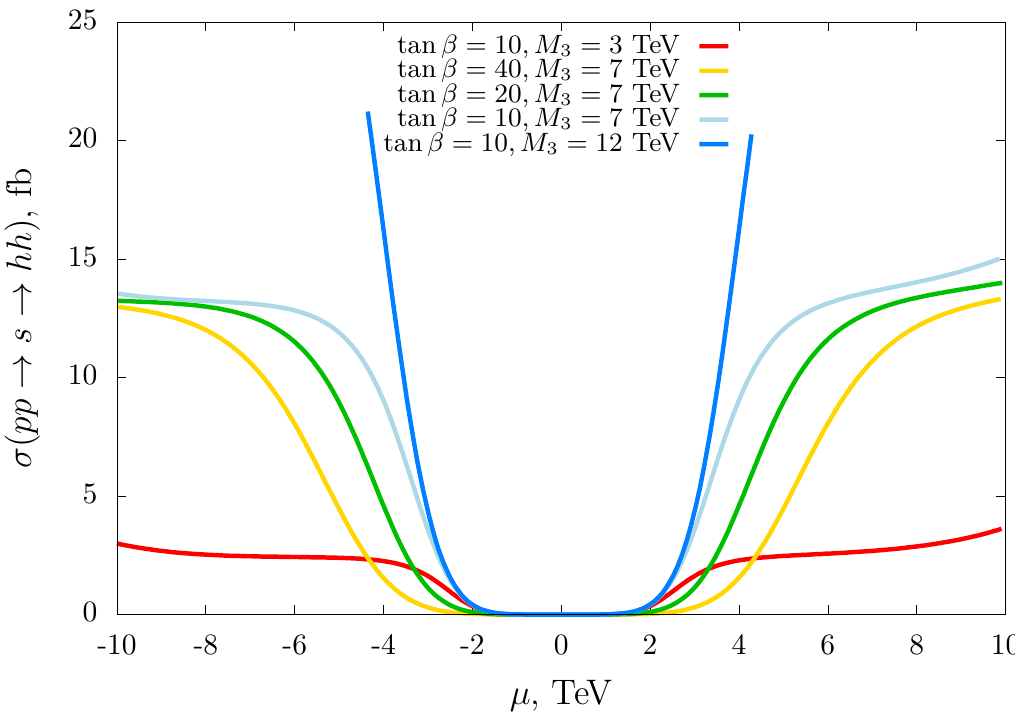
s hh calculated for ! ! s = 1 TeV, m A = 5 TeV, M 1 = M 2 = 1 TeV,